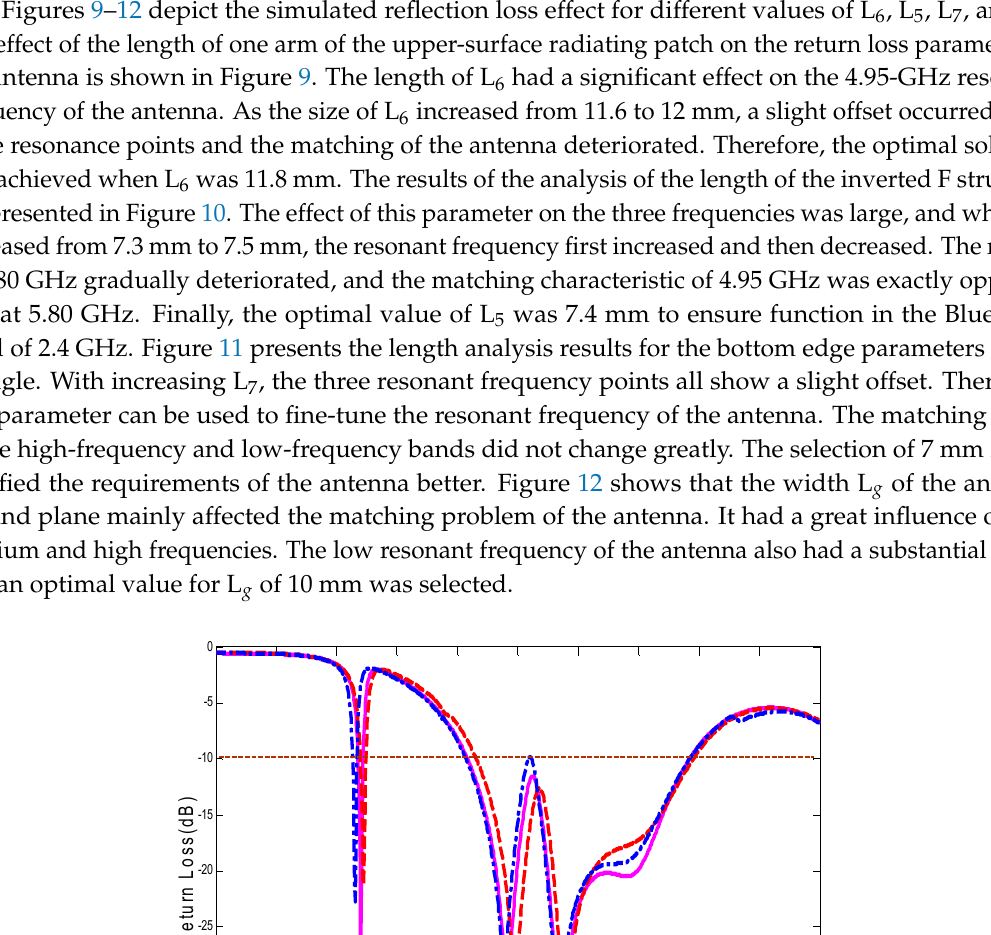
Figure 8. Surface current distribution (V/m) of the proposed antenna at ( a ) 2.45 GHz, ( b ) 4.95 GHz, and ( c ) 5.80 GHz.